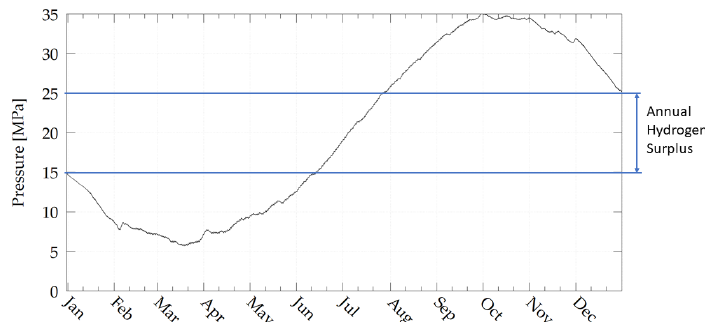
Figure 12. Annual progression of the hydrogen storage pressure with SWTs.